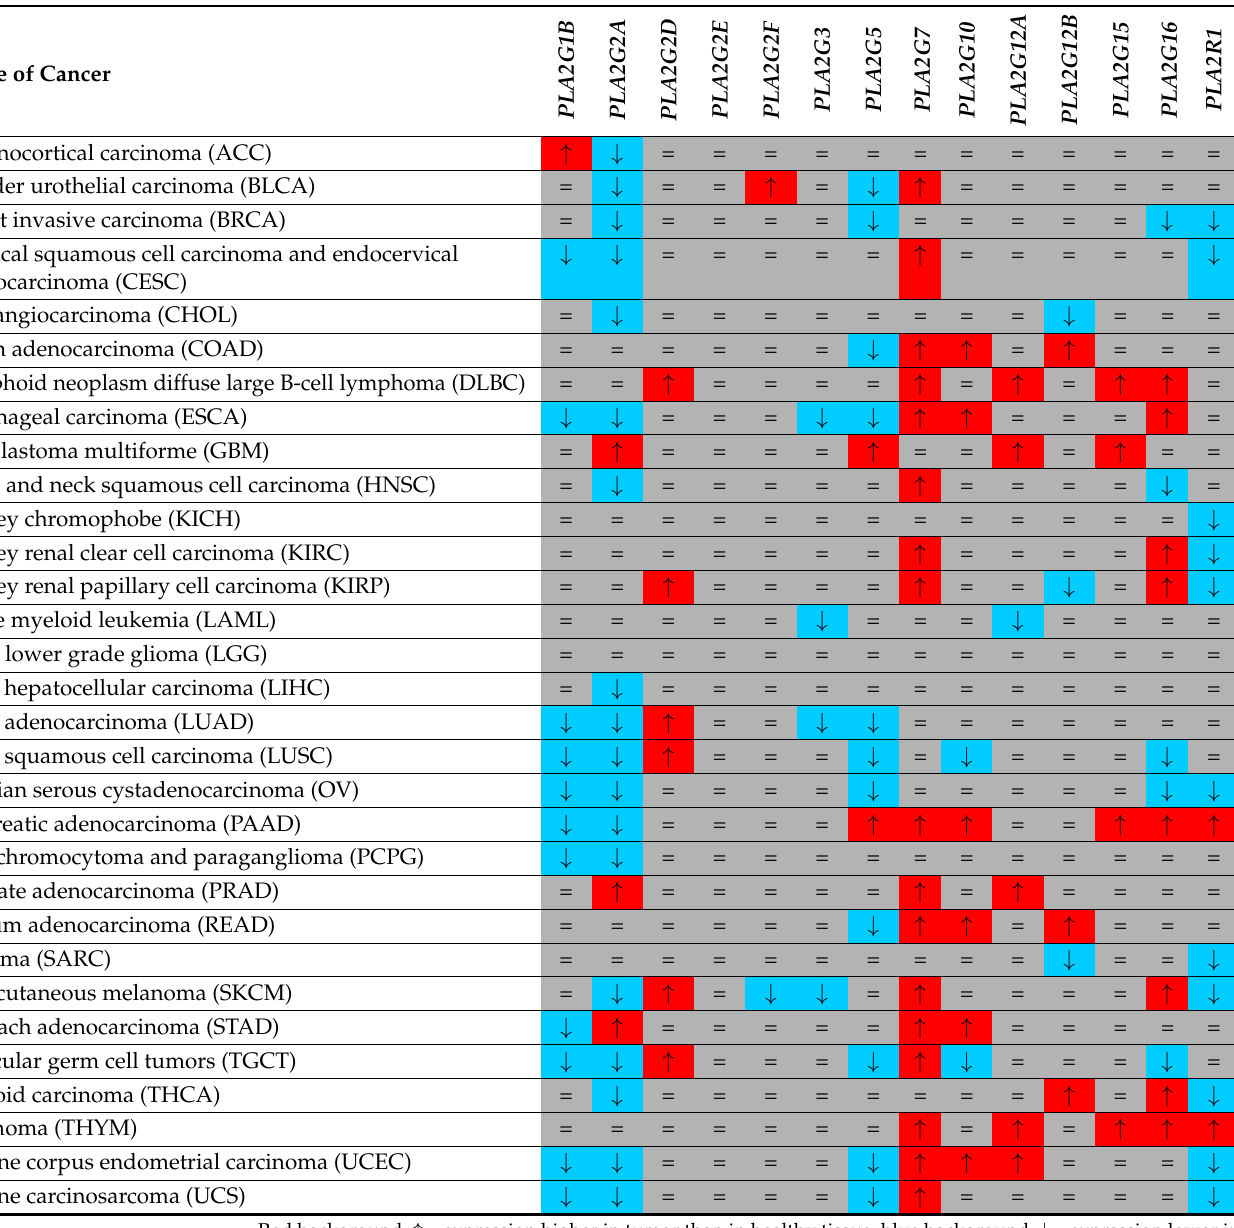
Table 4. Pan-cancer analysis of gene expression of sPLA 2 and sPLA 2